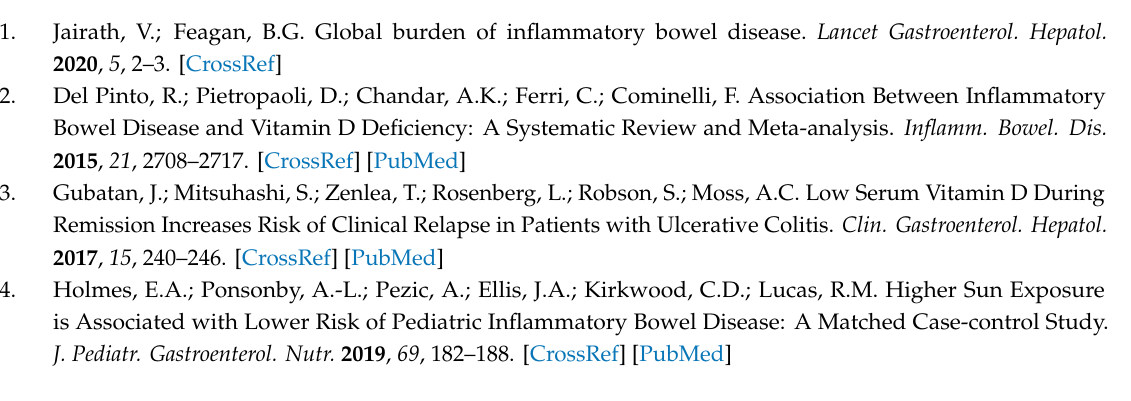
Table S1: Epidemiological patient characteristics, Table S2: Clinical characteristics of patients with inflammatory bowel diseases depending on insolation at diagnosis, Table S3: Clinical characteristics of patients with ulcerative colitis depending on insolation, Table S4: Clinical characteristics of patients with inflammatory bowel diseases depending on the season of diagnosis, Table S5: Clinical characteristics of patients with ulcerative colitis depending on the season of